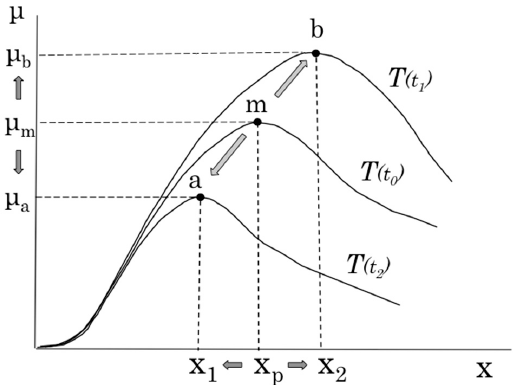
Figure 3. Change in throughput characteristics using the scaling operation.